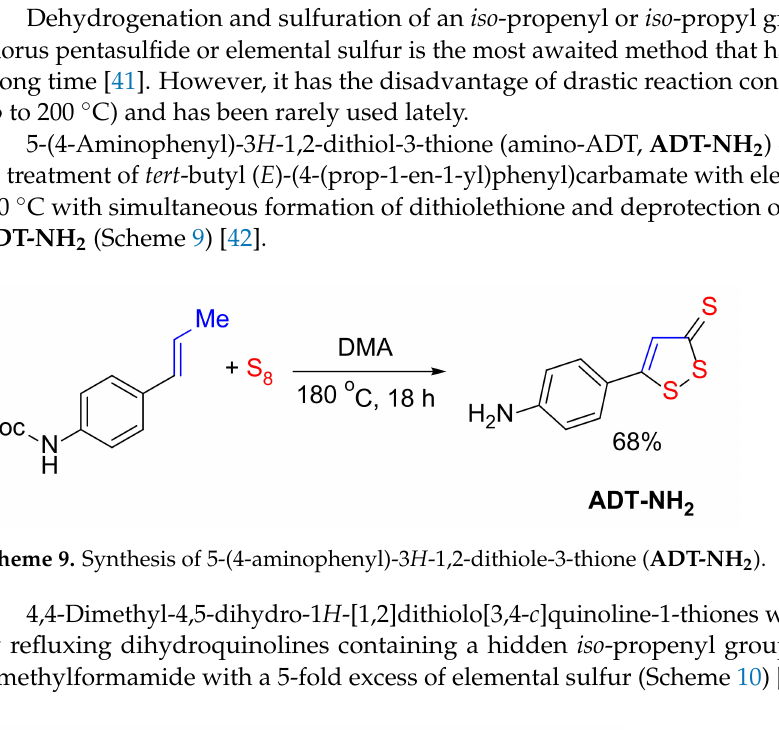
2.3. Synthesis of 3H-1,2-dithiole-3-thiones from Iso-Propenyl